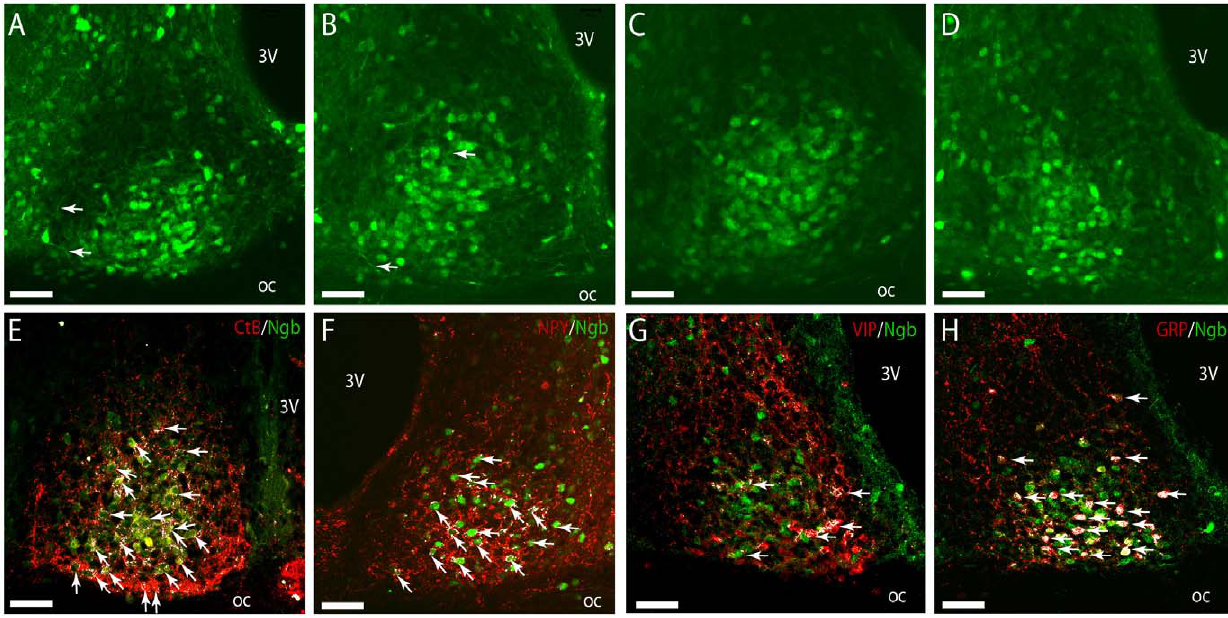
Figure 6. Innervation and co-expression of Ngb in the mouse SCN. In A–D Ngb-IR (green) can be seen in both the neuronal cell body and processes throughout the mid and ventral part of the SCN. Highest expression of Ngb-IR was observed in the mid/core part of SCN from rostral ( A ), mid ( B–C ) and in the ventral-lateral part in the caudal SCN ( D ). In ( E ) visual input from the RHT is depicted with cholera toxin subunit B (Ctb) (red). A high degree of innervation of Ngb-IR cells (green) was observed in the ventral and mid part of the SCN shown with white colour (arrows). Likewise Ngb-IR cells were also innervated by NPY-IR fibres (red) originating from the GHT (arrows) ( F ). In colchicine treated mice no co-expression of Ngb-IR and VIP-IR could be seen ( G ). Most GRP-IR cells were seen to co-express Ngb-IR (arrows) in colchicine treated mice ( H ). Oc; optic chiasm; 3 V, 3 rd ventricle. Scale bars 50 m m.